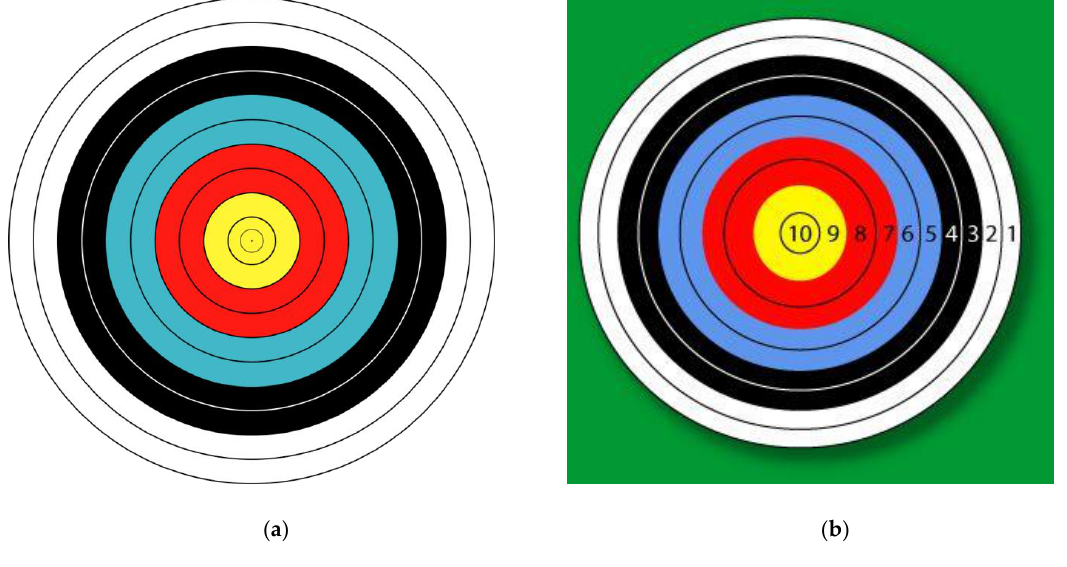
Figure 8. Description of target archery.